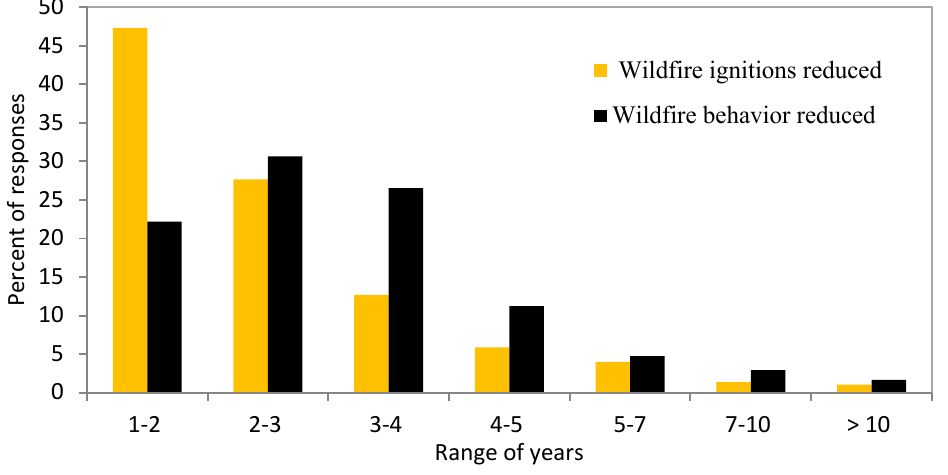
Figure 4. Overall response rates depicting the role of prescribed fire in reducing wildfire ignitions or wildfire behavior (rate of spread, flame length, area burned) as a function of years since the most recent prescribed burn was conducted for a given area. Unequal categories were used because burn programs typically include the given ranges of years rather than exact